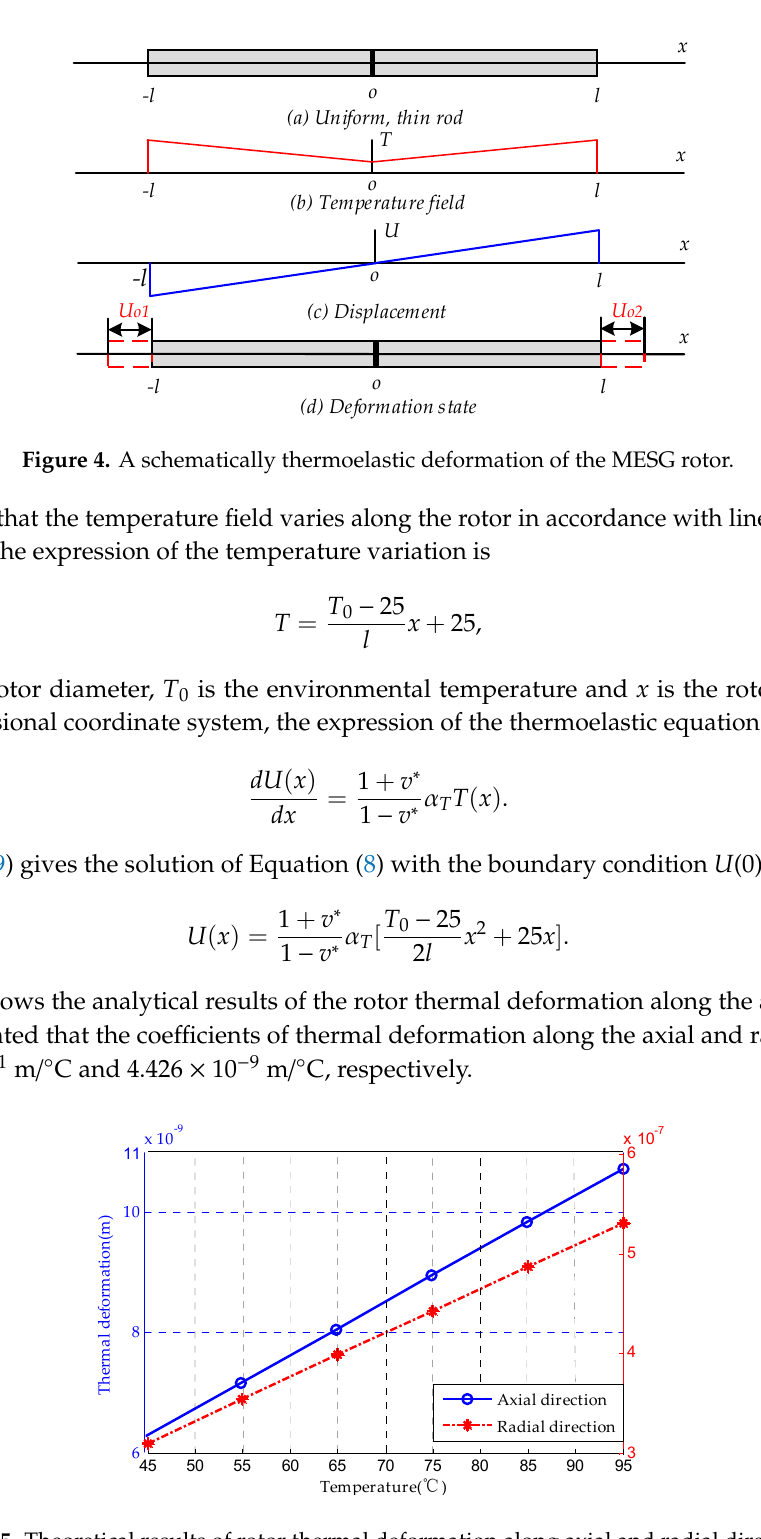
Figure 5. Theoretical results of rotor thermal deformation along axial and radial directions.